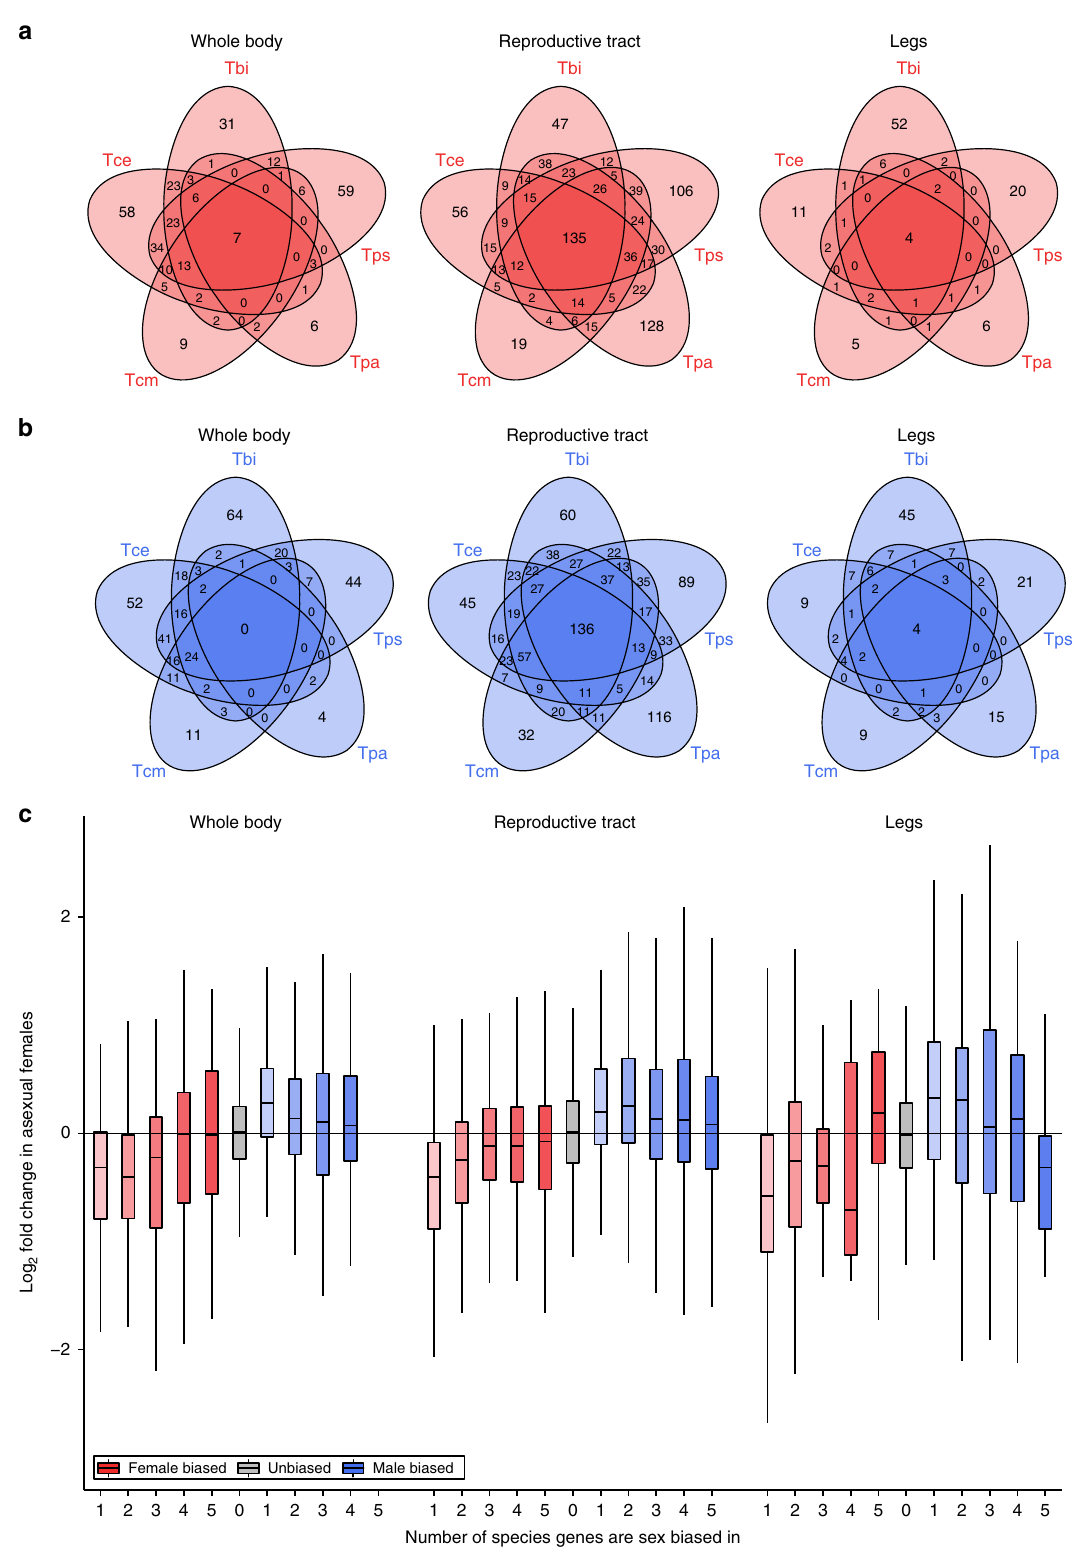
Fig. 5 Sex-biased genes across Timema species. a Venn-diagrams showing the overlap of female-biased genes. b Venn-diagrams showing the overlap of male-biased genes. c Boxplots showing the change in expression of female-biased (reds) and male-biased (blues) genes in asexual females when a gene is female or male-biased in 1, 2, 3, 4 or 5 sexual species. Note for genes sex-biased in multiple species the plot includes fold-change values of that gene in each species it is sex-biased in. Boxes represent the interquartile range (25th and 75th percentiles) of the data with the line inside the box representing the median. Whiskers show the most extreme value in the data which is no more than 1.5 times the interquartile range from the box. Source data are provided as a Source Data fi